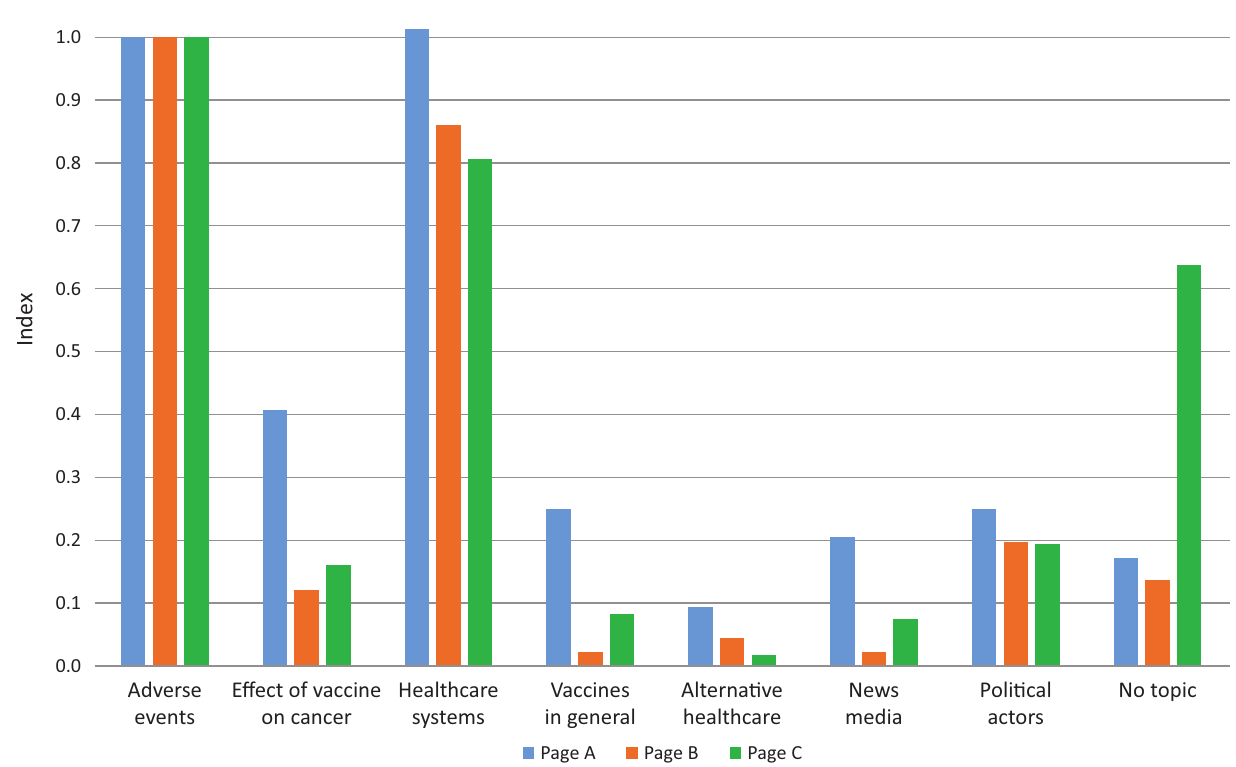
Figure 2. Relative frequencies of topics normalized by the frequency of ‘adverse events’ (1.0) for each page. Notes: The healthcare systems category in this figure subsumes the three levels in the healthcare system subcategory presented